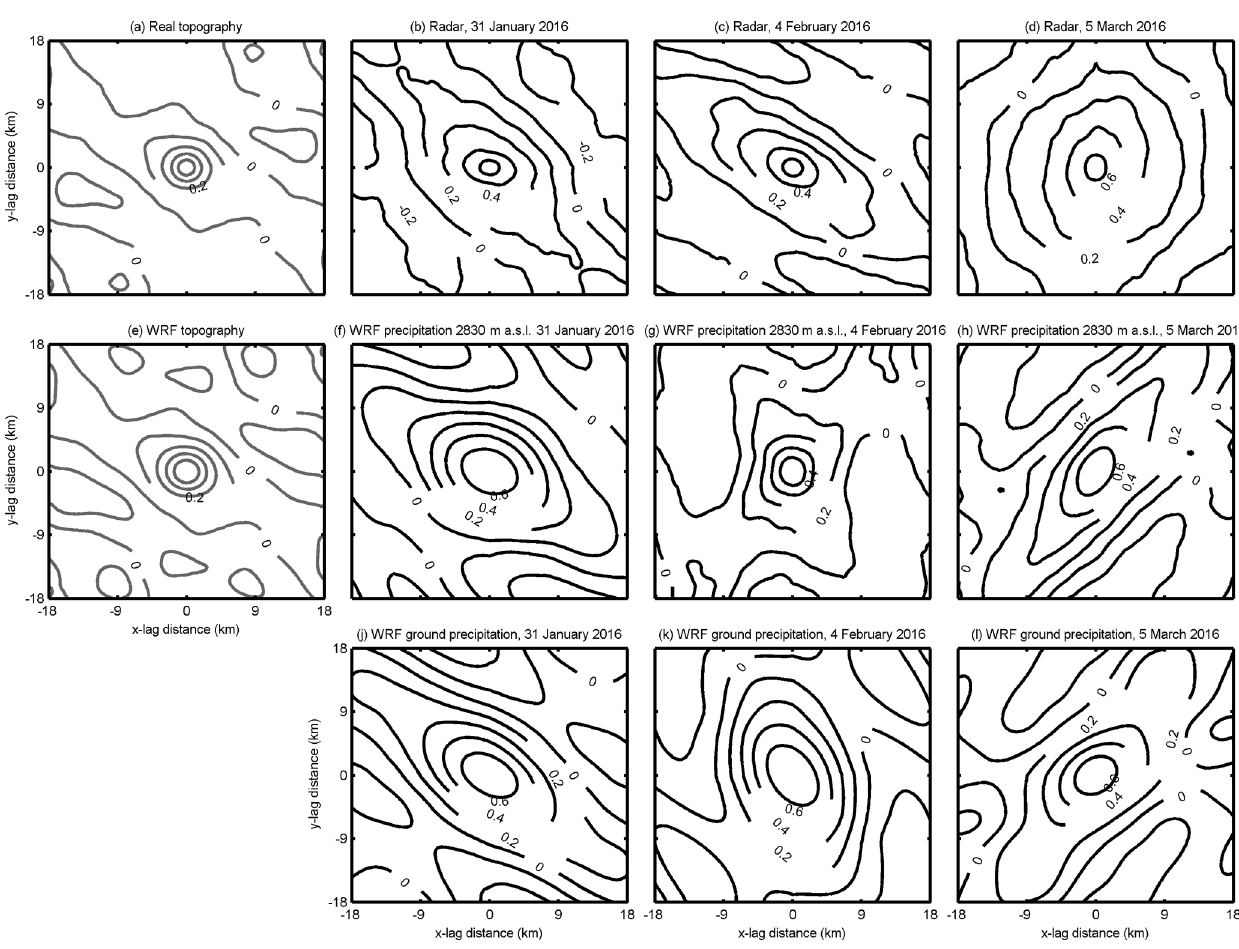
Figure 8. Spatial 2-D autocorrelation maps for the regional domain (450m resolution) of detrended (a) real topography (based on dhm25 © 2018 swisstopo (5740000000)), (b–d) entirely filtered radar snow precipitation, (e) WRF topography, (f–h) WRF snow precipitation at 2830m above sea level (ma.s.l.) and (j–l) WRF total ground precipitation. Autocorrelation maps of snow precipitation are for the three snow precipitation events on 31 January, 4 February and 5 March 2016. WRF topography and precipitation are from simulations with weak terrain smoothing (Sect. 2.1). Radar precipitation and WRF precipitation at 2830ma.s.l. are masked (as shown in Fig.